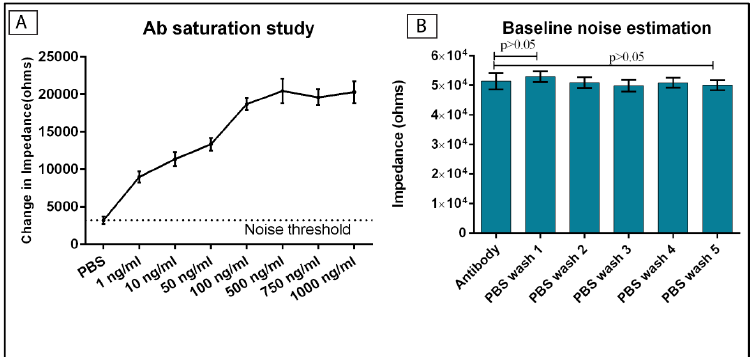
Figure 3. Antibody conjugation analysis. ( A ) Analysis of antibody saturation study on the dithiobis succinimidyl propionate (DSP) functionalized Mo sensor. The dotted line indicates the noise threshold. Error bars indicate the standard error of mean from n = 3 replicates; ( B ) Baseline noise estimation on antibody conjugated biosensor and multiple PBS wash steps post the Ab conjugation. The impedance values for the phosphate-buffered saline (PBS) wash steps are statistically insignificant compared to the impedance obtained post the antibody incubation.